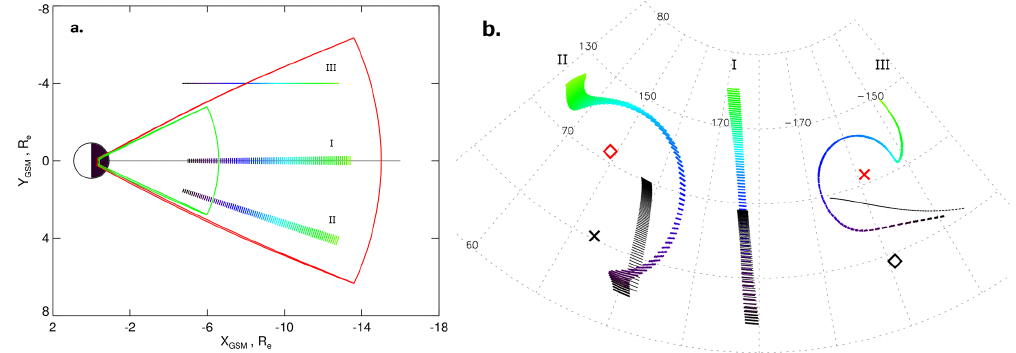
Figure 4. (a) Equatorial locations of three hypothetical narrow plasma streams; (b) their ionospheric footprints. The black strips indicate stream mapping using the background IGRF + T89 model; the colored strips represent stream mapping in the IGRF + T89 + SCW2L model ( I 1 = 1MA, I 2 = 0.5MA, R1 = 15Re, RT 2 = 6Re and RCF = 6). Color coding indicates the streamers, spatial orientation or movement direction.